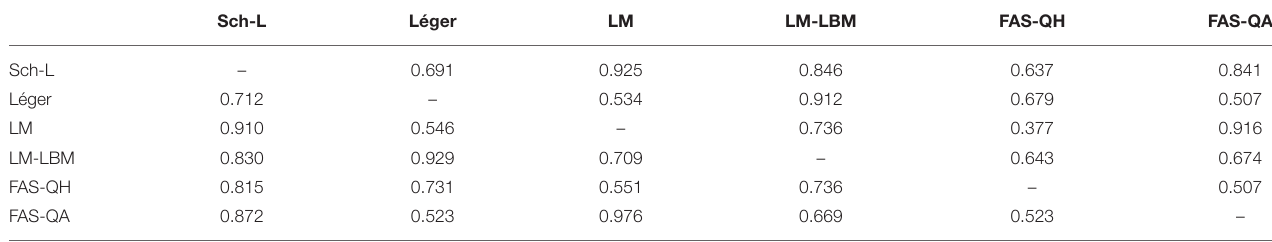
TABLE 3 | Coefficients of determination between estimated glomerular filtration rate returned by six formulae in males (right upper corner) and females (lower left corner). Sch-L Léger